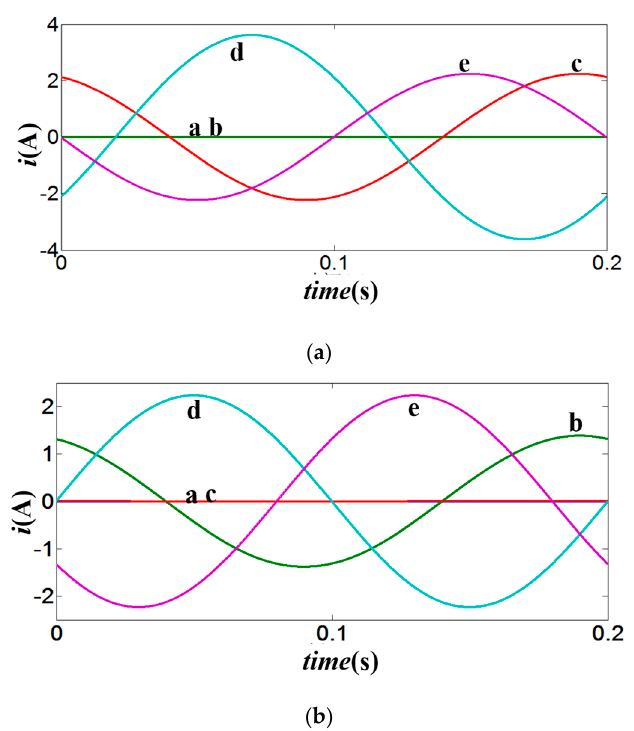
Figure 6. Fault phase fault-tolerant control law: ( a ) AB fault-tolerance; ( b ) AC fault-tolerance.